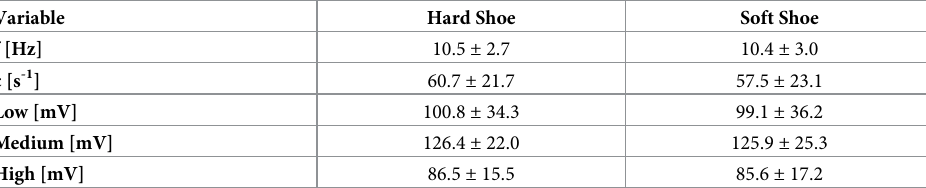
Table 1. Vibration characteristics.